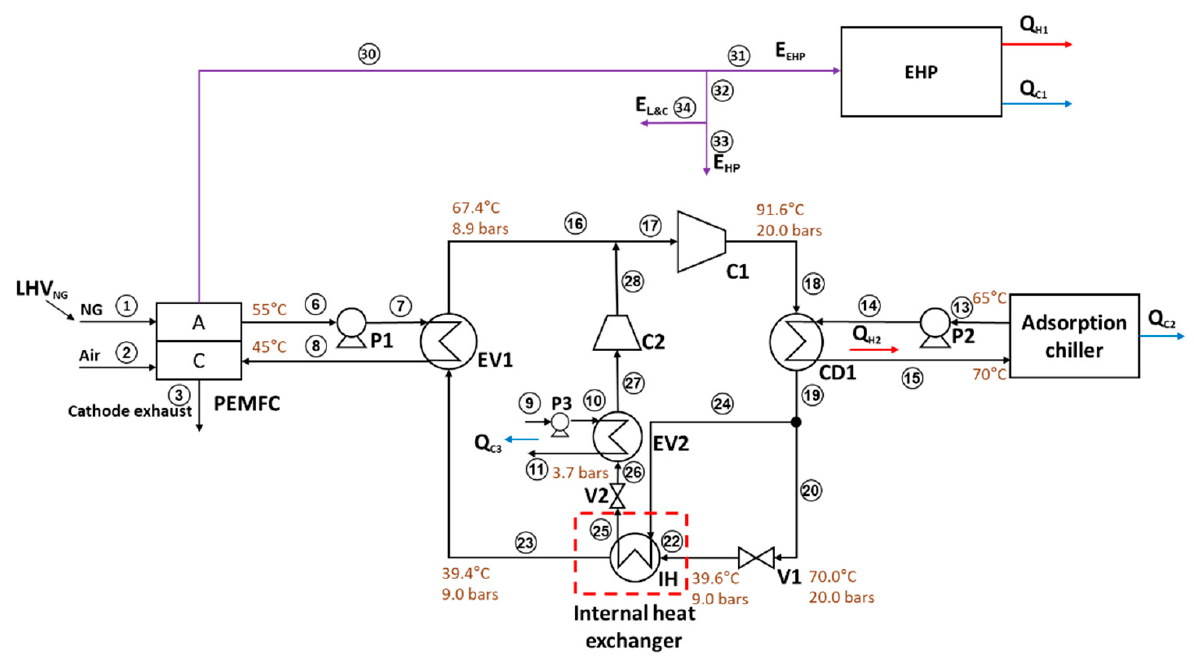
Figure 4. Proposed layout with an internal heat exchanger (case C).